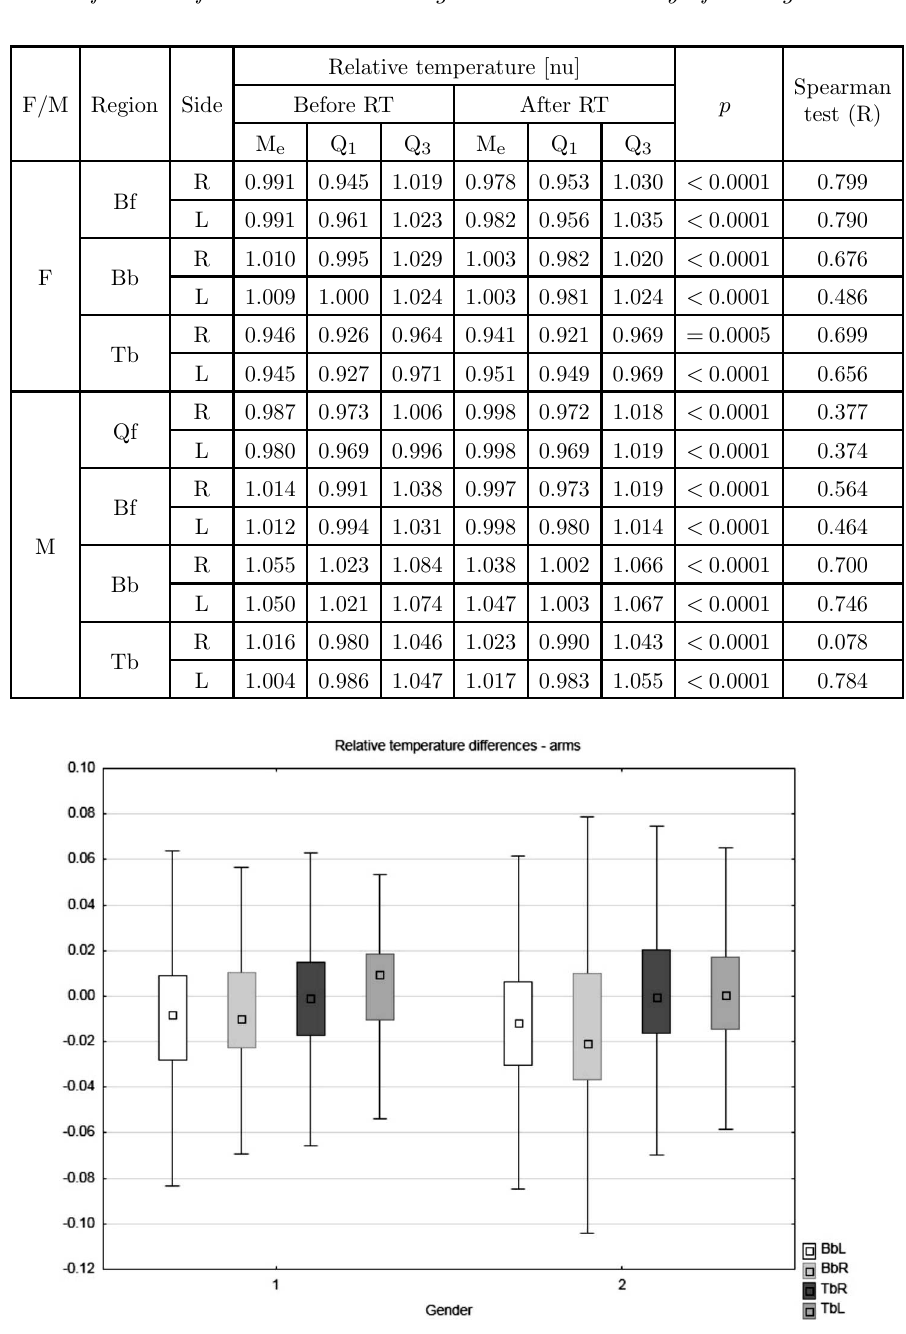
Figure 2. Changes in relative T sk in upper extremities for male (1) and female (2) subjects before and after